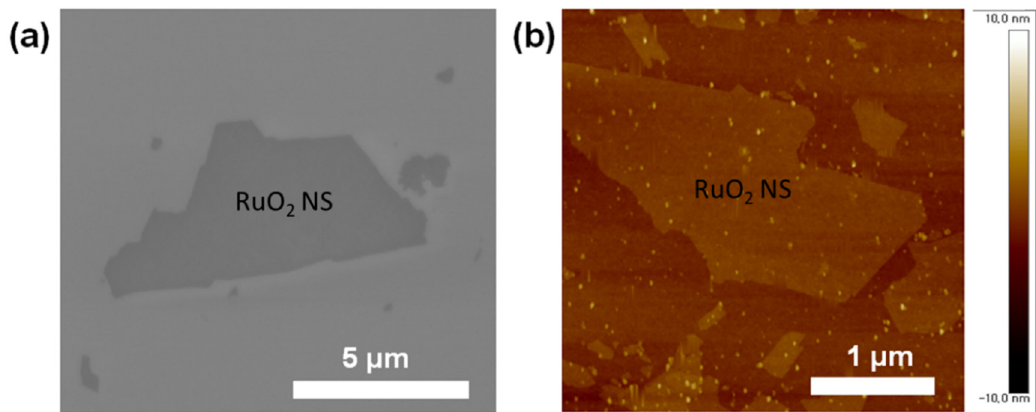
Figure 1. Characterization of RuO 2 nanosheets. ( a ) FE-SEM image of a RuO 2 nanosheet (NS) with a large lateral diameter. ( b ) AFM image of a chemically exfoliated RuO 2 NS.